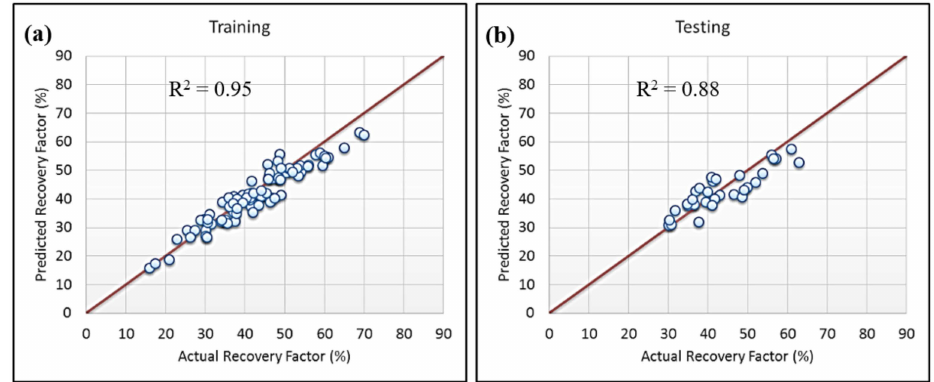
Figure 3. Predicted vs. actual recovery factor based on the radial basis neuron network (RNN) model ( a ) training dataset, ( b ) testing dataset.